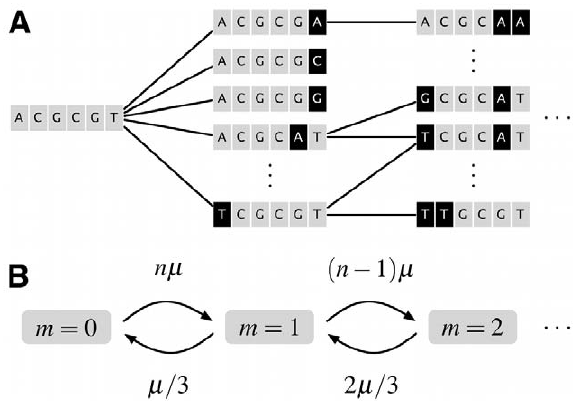
Figure 2. Condensed mutational network for a single binding site. (A) Mutational network for the Mbp1 canonical binding site [28]. Two sequences are connected if they differ by one base pair and the probability of any of these transitions is one-third of the mutation rate per base pair per generation ( m = 3 ). (B) Condensed version of the mutational network in (A). Genotypic classes were obtained by grouping all sequences at the same Hamming distance ( m ) from the canonical sequence. The probabilities of moving between genotypic classes are shown ( n is the length of the binding site).